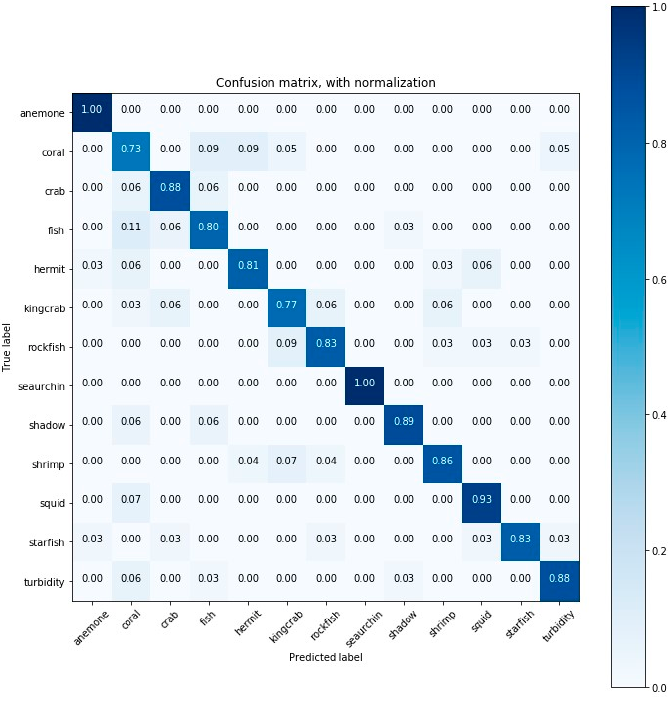
Figure A12. Confusion matrix for the classification results (accuracy) obtained by DNN-2. Sensors 2020 , 20 , 726